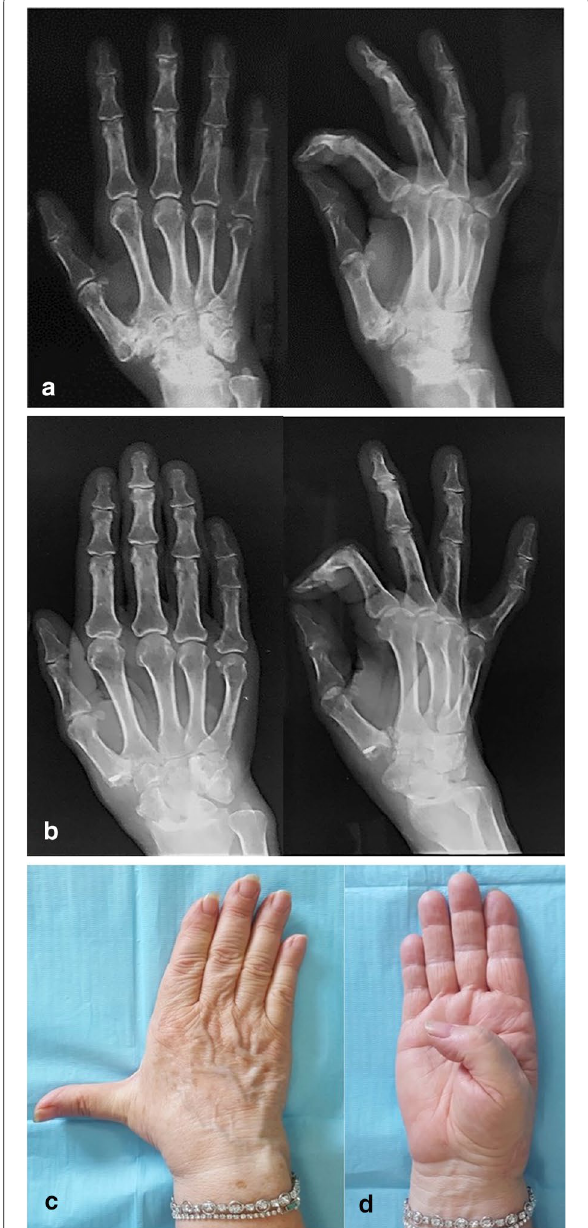
Fig. 2 a Preoperative radiographs of the right hand showing severe trapezio-metacarpal osteoarthritis in a 57-year-old woman, complicated by pain and disability of the thumb. b At follow-up, 9 years after surgery, X-rays did not show proximal migration of the thumb metacarpal or signs of impingement on the scaphoid. c , d Clinical evaluation showed excellent abduction and joint opposition of the thumb. Metacarpophalangeal hyperextension was evident, as is often observed as a consequence of this surgical procedure. In spite of the hyperextension of the thumb, the patient reported no pain or significant limitations in her daily